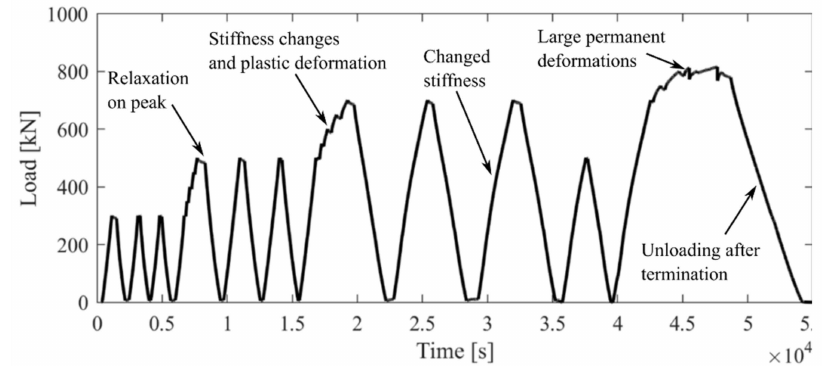
Figure 10. The achieved loading scheme.